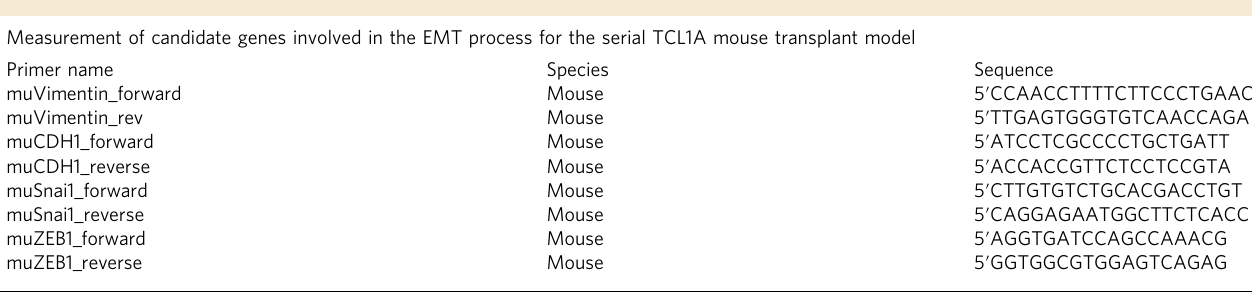
Telomere measurement by quantitative PCR adapted from Richard Cawthon, Nucleic Acids Res. 2002 May 15;30(10):e47. Primer name Species Sequence Telo